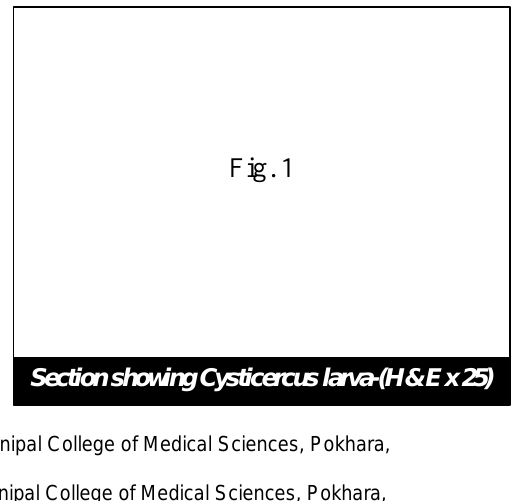
Section showing Cysticercus larva-(H & E x